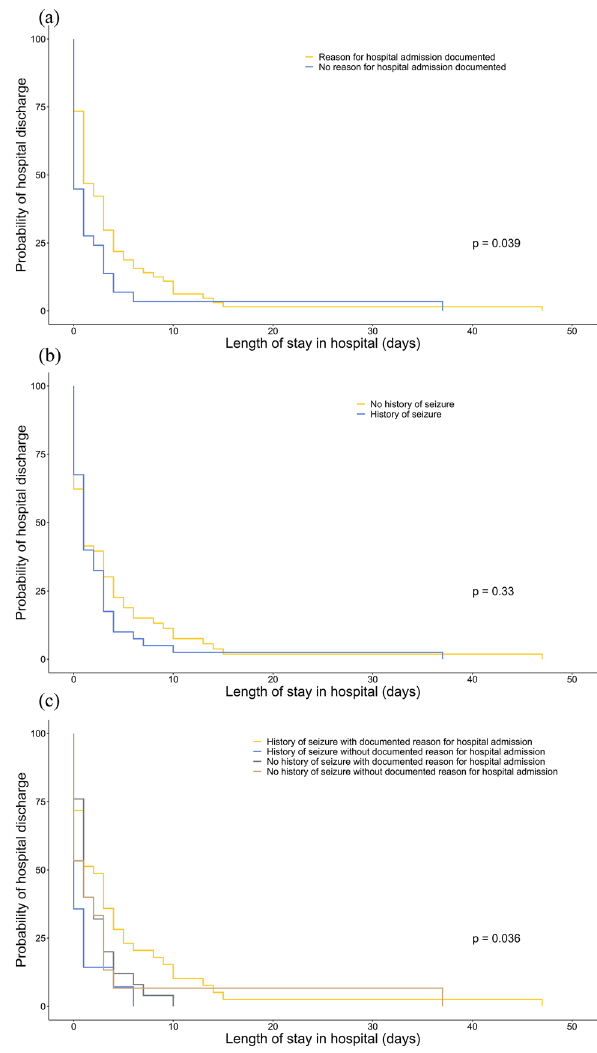
Figure 2. Probability of hospital discharge. Probability of hospital discharge stratified by a documented transportation reason ( a ) and history of seizure/epilepsy ( b ) presented as Kaplan–Meier-Curves. ( c ) Shows the combination of documented reason for admission and history of seizures. Yellow line indicates patients with a documented reason for hospital transportation ( a ) or no history of seizure/epilepsy ( b ); blue line indicates patients without documented reason ( a ) or history of seizure/epilepsy ( b ). Please see Supplementary Table 1 for possible transportation reasons as documented by the attending emergency